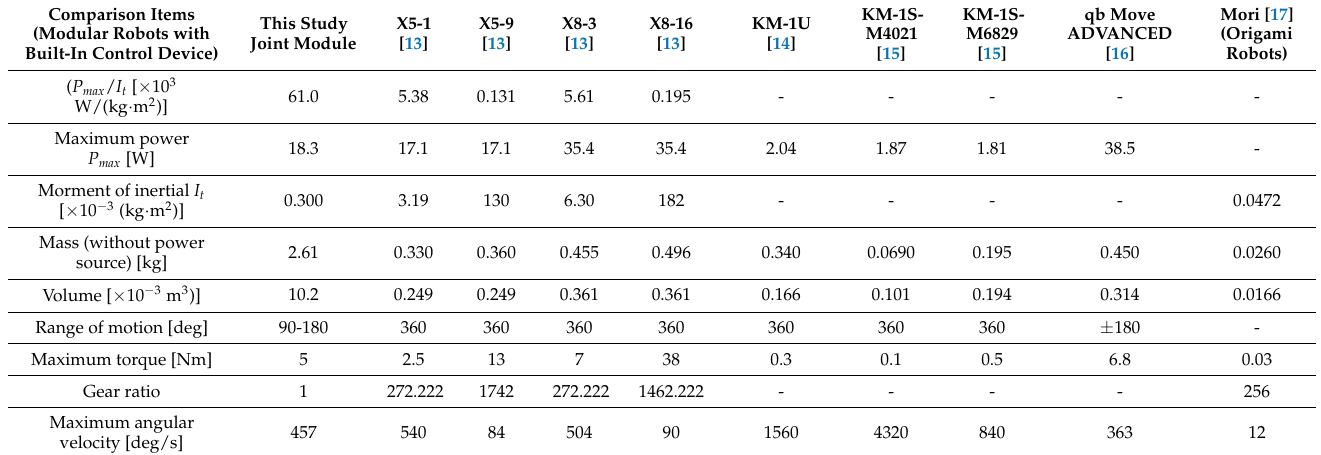
Table 4. Comparison table of a variable viscoelastic Joint Module and existing